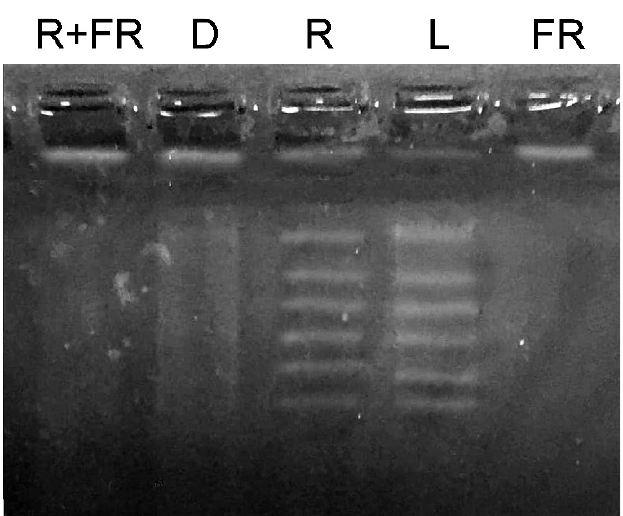
Figure 2. Methyl-specific restriction of genomic DNA from maize leaves under different light conditions. L, plants illuminated with white light; D, plants kept in darkness; R, plants illuminated with red (660 nm) light; FR, plants illuminated with far-red (730 nm) light; R+FR, plants illuminated with red (660 nm) followed by far-red (730 nm) light.